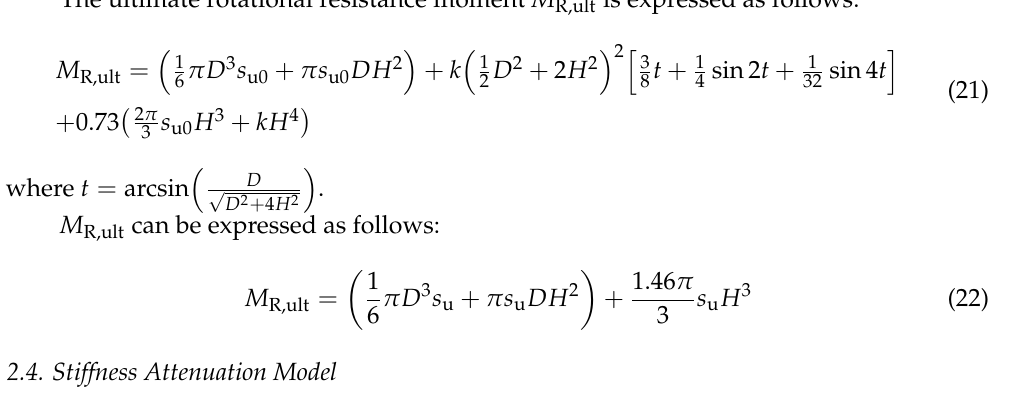
Figure 6. Shear failure resistance moment.